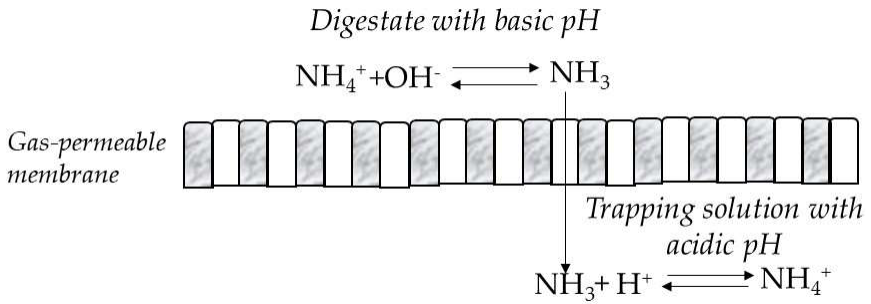
Figure 1. Cross-sectional diagram of a gas-permeable membrane.